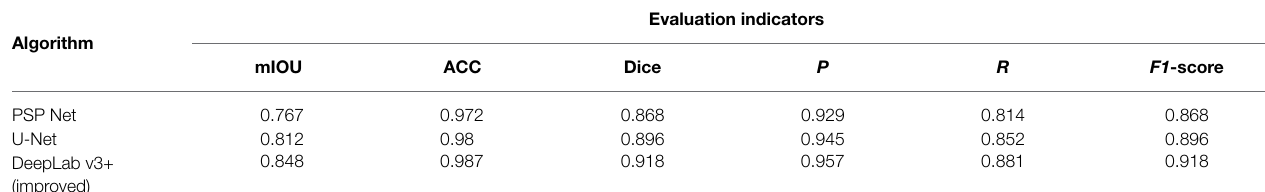
TABLE 6 | Statistical segmentation results of different segmentation algorithms on the test set TS1